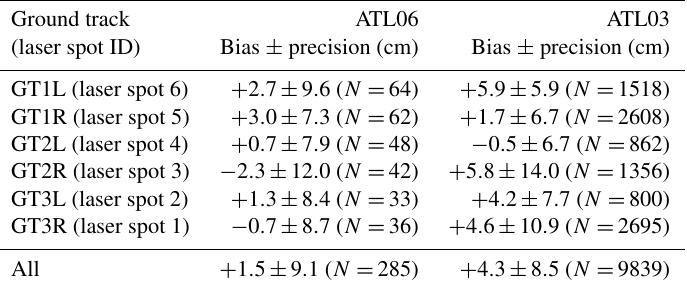
Table 2. Assessment of ICESat-2 ATL06 ice surface points and ATL03 photons using the GNSS PPK technique with direct ice surface measurements (within 5km of h 2 ) along the 36th CHINARE traverse. Bias and precision were estimated from their elevation differences using N ice surface points or photons. The difference is calculated as ICESat-2 elevation minus GNSS elevation. Ground track